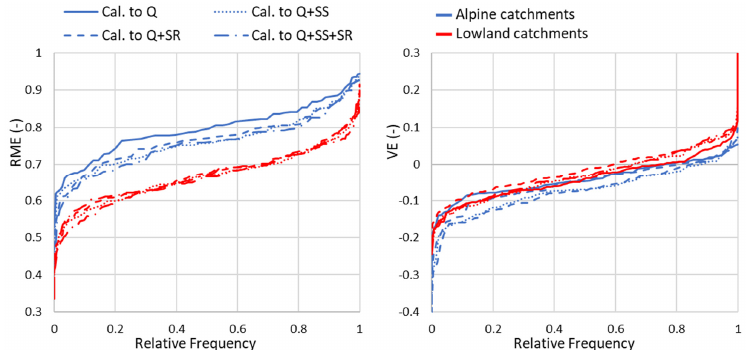
Figure 4. Cumulative distribution functions (CDFs) of the values of the runoff model efficiency (surface left) and runoff volume error (surface right) in the validation period 2015–2016. The CDFs were plotted for four calibration variants of the objective functions. The red and blue lines show the calibration variants for the group of 124 Lowland (red) and 65 Alpine catchments (blue), respectively. Table 4. Medians of the values of the runoff model efficiency (RME) and runoff volume error (VE) for the four calibration variants and two groups of catchments (65 Alpine and 124 Lowland) in the validation period 2015–2016.